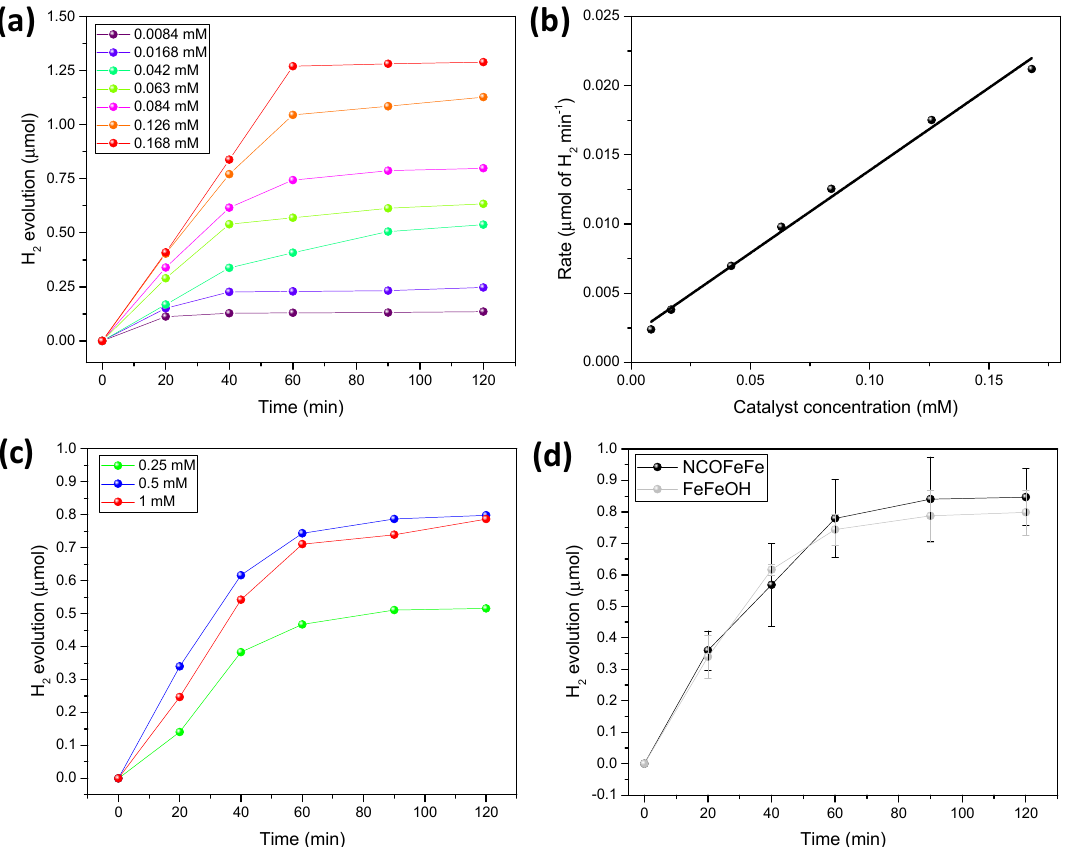
Figure 10. ( a ) Photocatalytic hydrogen production as a function of the FeFeOH catalyst concentration at pH = 5.0; ( b ) initial rate of H 2 formation versus the concentration of the FeFeOH catalyst obtained from the previous graph; ( c ) photocatalytic hydrogen production as a function of the [Ru(bpy) 3 ] 2+ photosensitizer concentration at pH = 5.0; and ( d ) comparison of the photocatalytic hydrogen productions between FeFeOH and NCOFeFe catalysts at pH = 5.0.